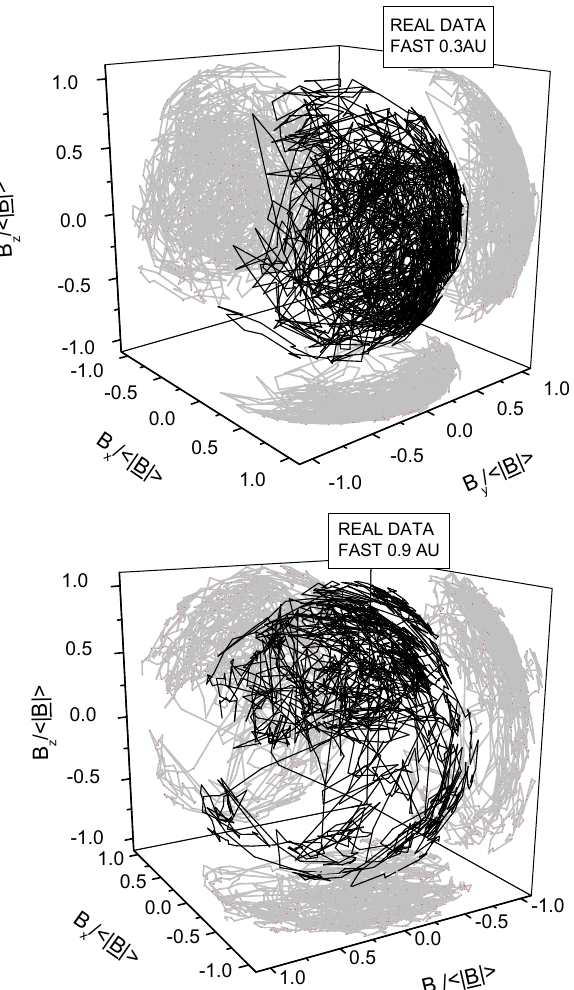
Fig. 3. The top panel refers to a slow wind recorded at 0.3AU while the bottom panel refers to slow wind at 0.9AU. The format is the same used for Fig. 2 and, also in this case, we show only 2000 points out of 28800 points of each selected time interval. Both configurations relative to 0.3 and 0.9AU greatly differ from what we observed within fast wind. In both cases a patchy configuration is clearly visible, meaning that the tip of the vector dawdles longer around some particular orientation. At first sight, the two panels show similar configurations, although fluctuations at 0.3AU appear to be slightly larger. Definitely, we do not observe the same radial evolution noticed for a fast